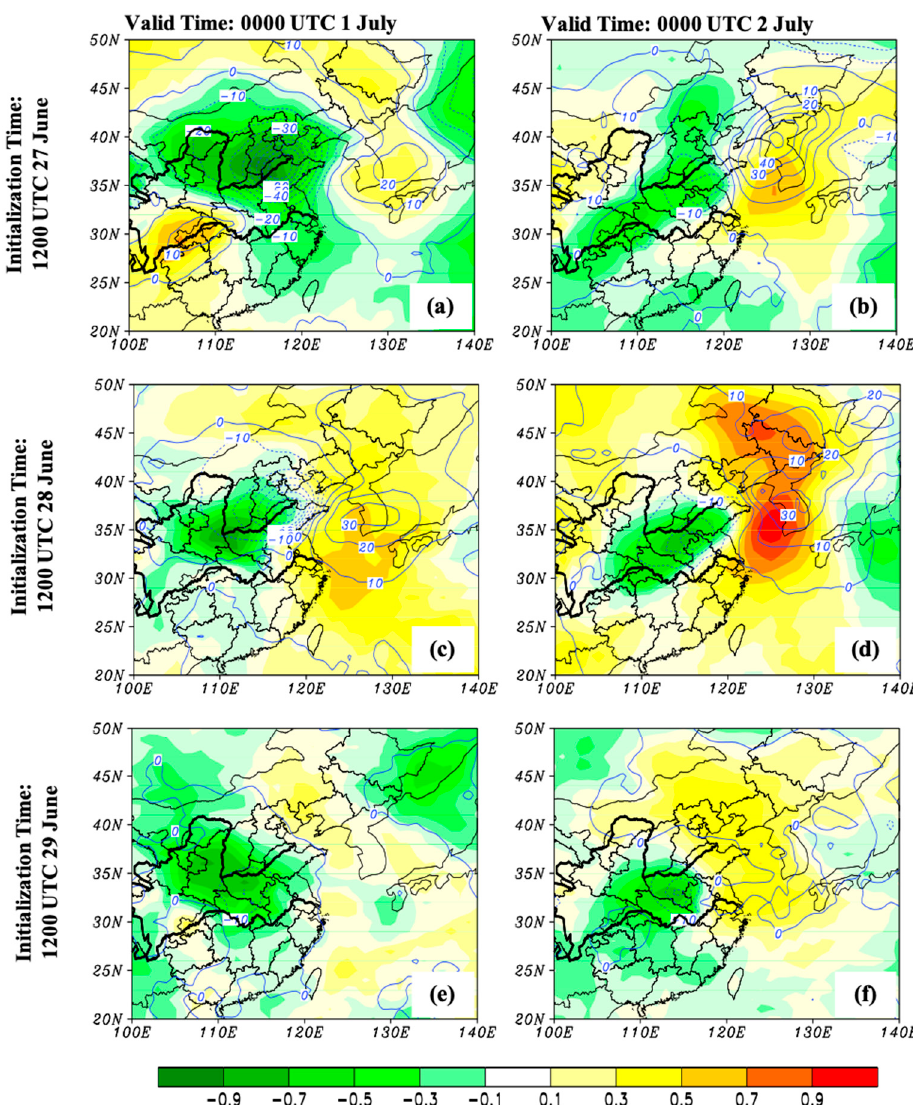
Figure 13. The ensemble-derived correlation coefficients between the forecasted RBI and the 500-hPa geopotential height (colored) along with the geopotential height difference between the NORTH subset and the GOOD subset (meters, blue contours (dashed negative), 10 m contour interval) valid at 0000 UTC of (a, c, e) 1 July and (b, d, f) 2 July for ensembles initialized at 1200 UTC 27 June ( a, b ), 28 June ( c, d ), and 29 June ( e, f ) 2016, respectively. Thin black contours denote political boundaries and thick black lines denote the Huanghe and Yangtze Rivers to the north and south, respectively.